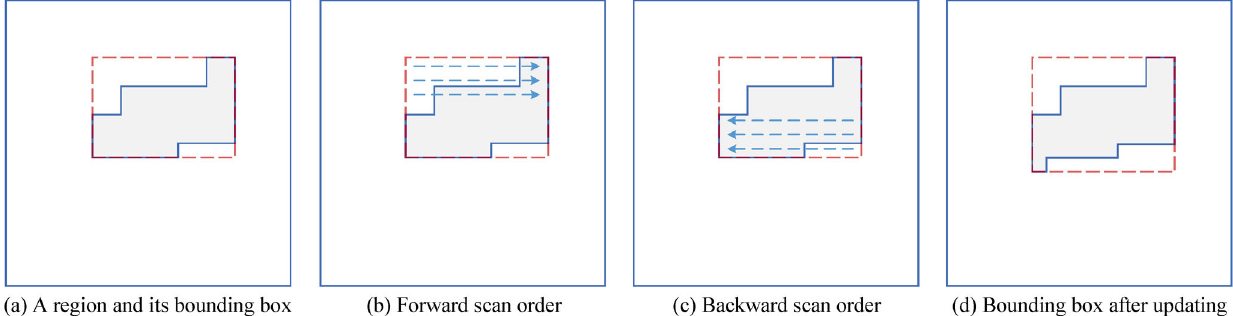
Fig. 2 Scanning order for each superpixel. Gray regions enclosed by blue lines represent superpixels. Red dashed rectangles denote their corresponding bounding boxes. We first scan the bounding box from left to right and top to bottom (b) and then in the opposite direction (c). The shape of each superpixel may change, whereupon we update the bounding box (d) if